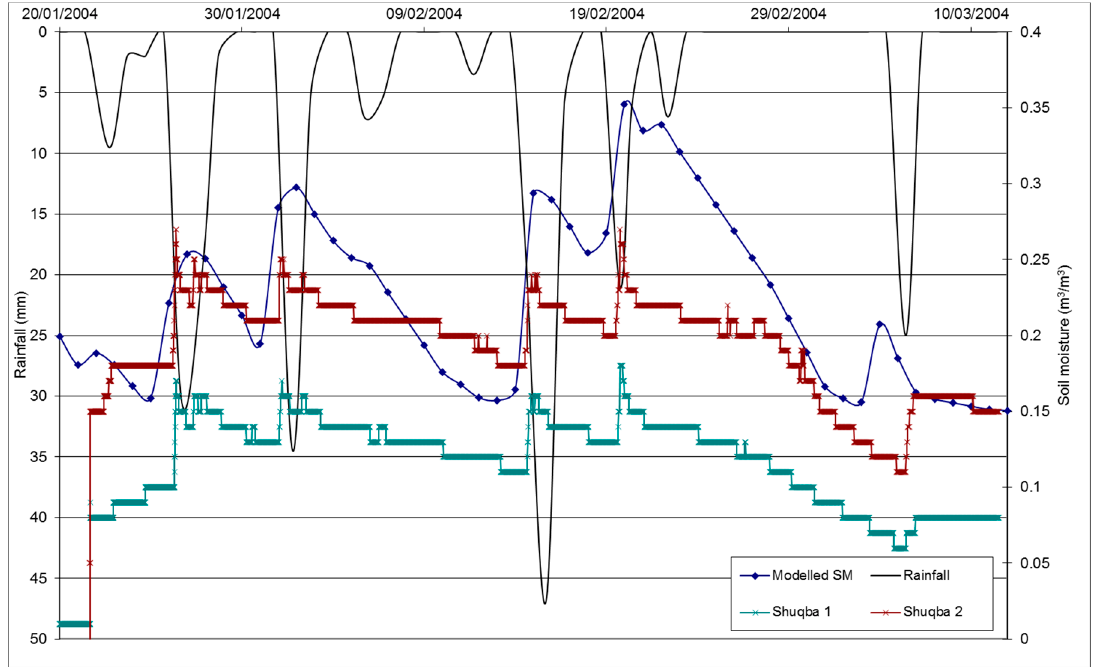
Figure 6. Comparison between modeled and observed soil moisture content for Shuqba (Winter 2003/04).